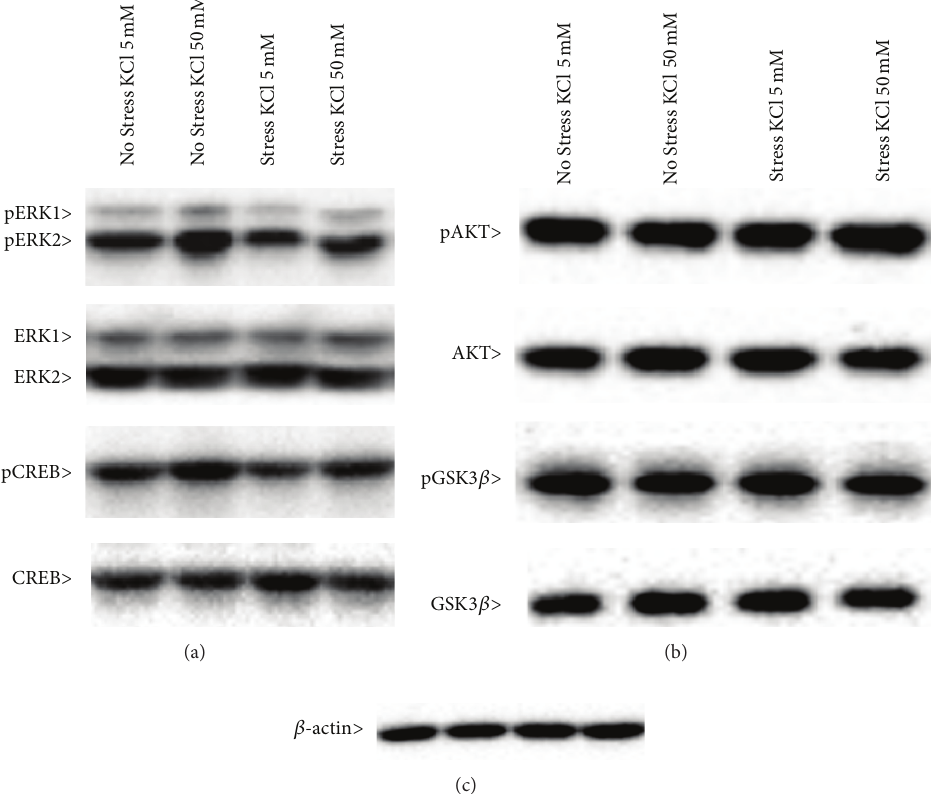
Figure 4: Representative Western blot analyses of the phosphorylated forms of ERK1, ERK2, and CREB (a) and of AKT and GSK3 𝛽 (b) and their total forms (a and b). 𝛽 -actin was used as internal standard (c). Experimental conditions are described in Methods.